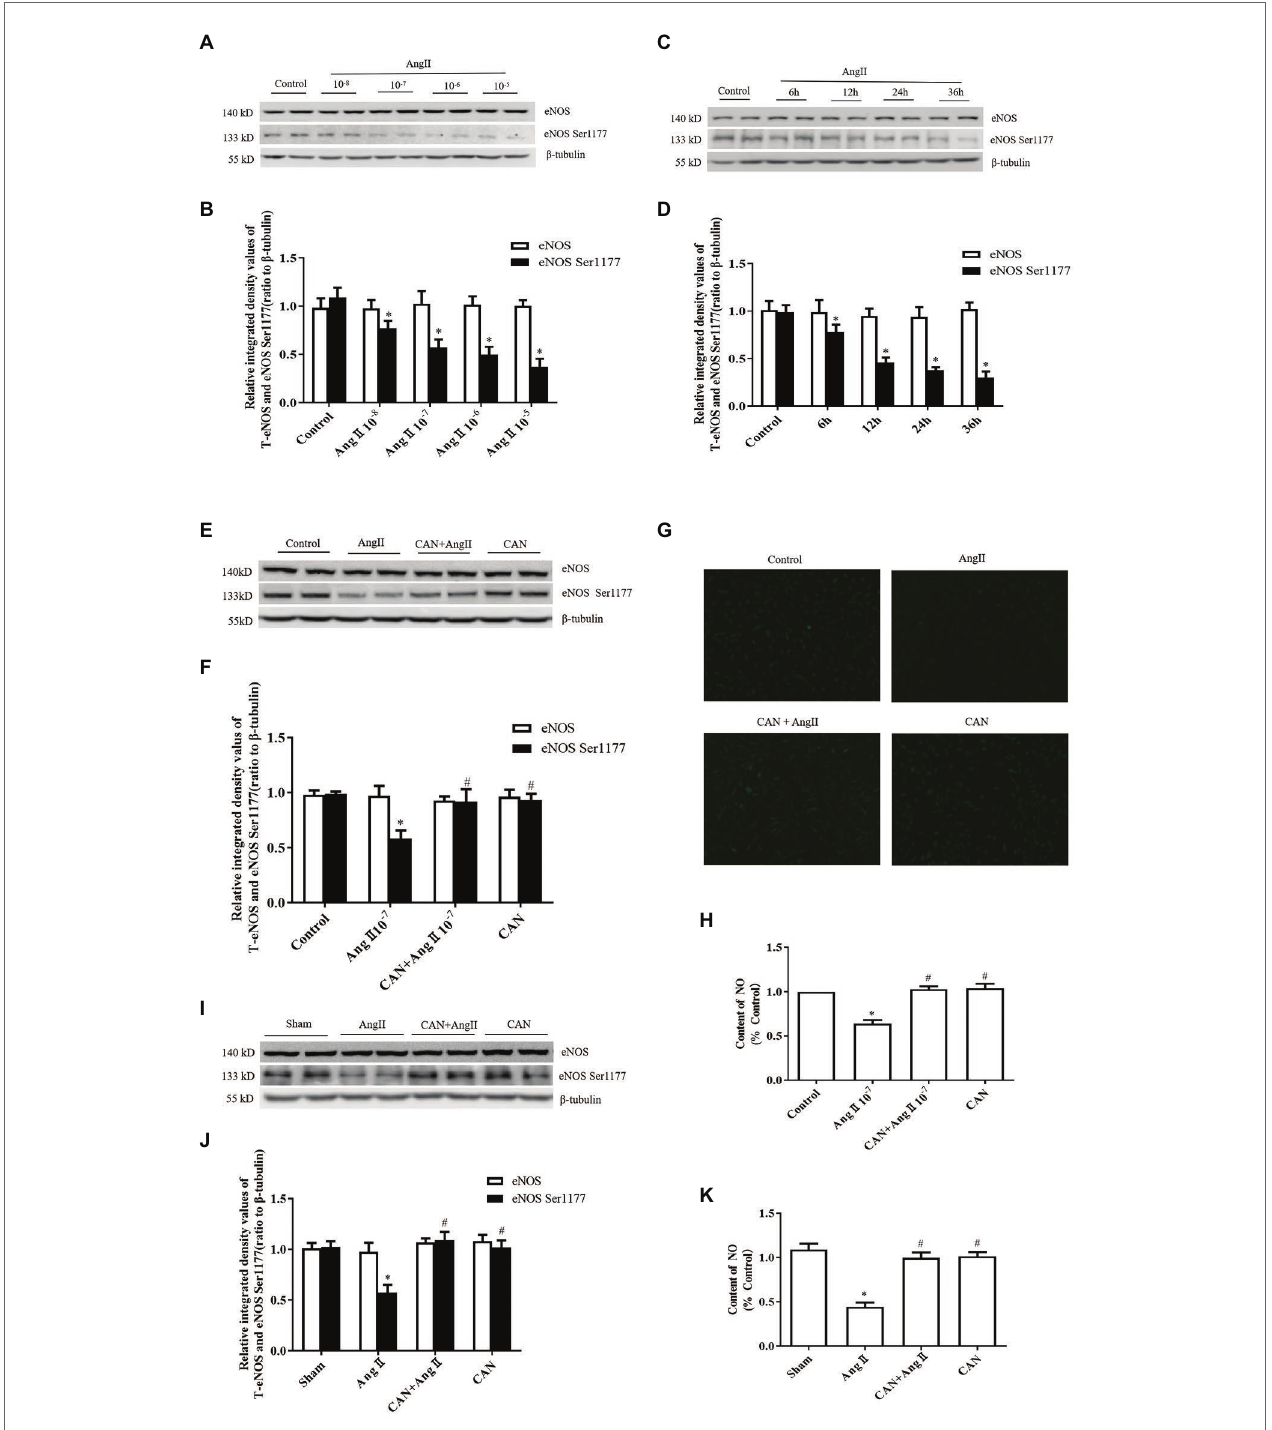
FIGURE 1 | Effects of the angiotensin II (AngII)/angiotensin type 1 receptor (AT 1 R) pathway on endothelial nitric oxide synthase (eNOS) Ser1177 phosphorylation and nitric oxide (NO) production. (A,B) AngII downregulated phosphorylation levels of eNOS Ser1177 in a dose-dependent manner. Human umbilical vein endothelial cells (HUVECs) were treated with the indicated concentrations of AngII for 12 h, and phosphorylation levels of eNOS Ser1177 were detected by Western Blot analysis ( n = 6 independent experiments). (C,D) AngII downregulated phosphorylation levels of eNOS Ser1177 in a time-dependent manner. HUVECs were treated with 10 −7 M AngII for the indicated time, and phosphorylation levels of eNOS Ser1177 were detected by Western Blot analysis ( n = 6 independent